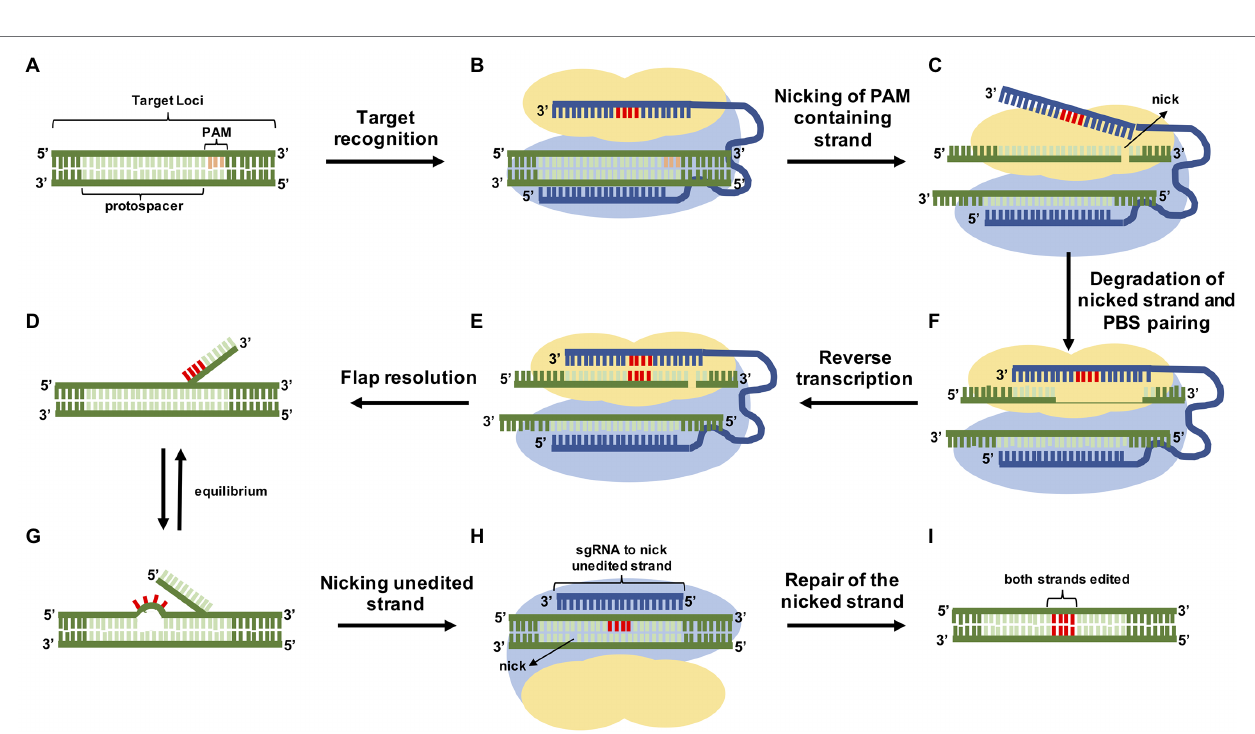
FIGURE 2 | Components of the Prime editing technique. (A) Cas9 nickase (Cas9n) is fused to a Reverse Transcriptase (RT) to form the Prime editing protein complex. (B) The pegRNA contains the Prime Binding Site (PBS) which is used to prime the reverse transcriptase reaction, the template containing the desired edit and the spacer that will guide the Cas9n to the target.